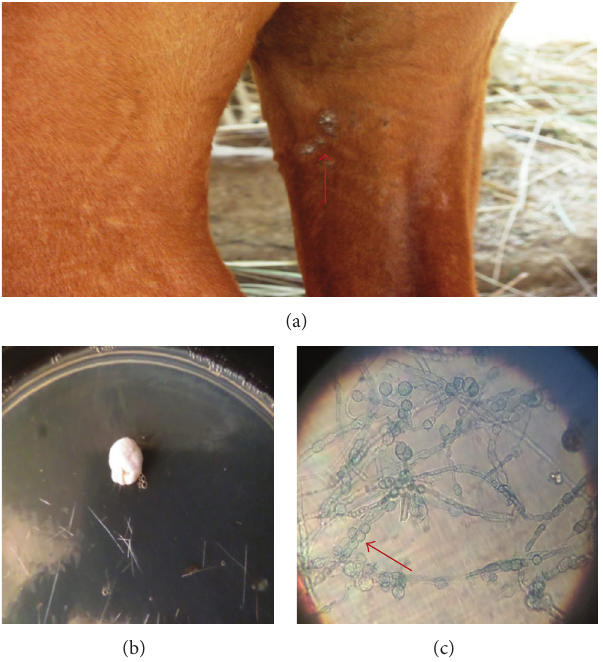
Figure 5: Dermatophytosis caused by T. verrucosum on the limb of a horse (a), slow growing button shaped colony of T. verrucosum (12